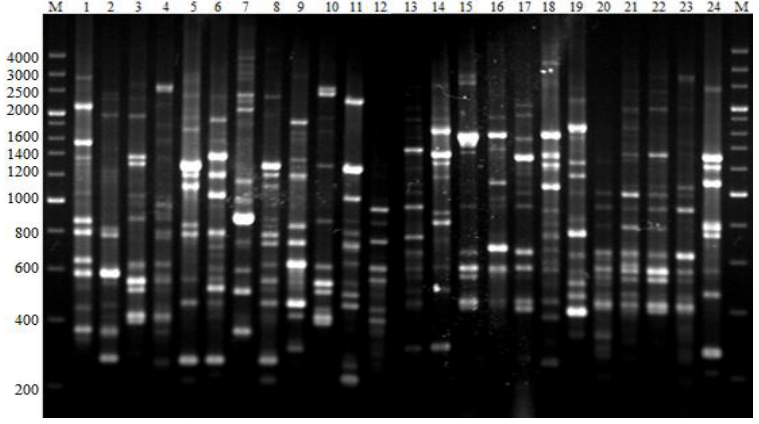
Figure 2. PCR DNA fingerprints generated with primer BOXAIR. Lanes (1–24) represent the BOXAIR groups 1, 2, 4, 5, 6, 8, 10, 11, 12, 13, 16, 18, 19, 20, 21, 23, 25, 26, 27, 29, 30, 31, 33 and 35. Lanes M are the marker 200 bp DNA ladder.